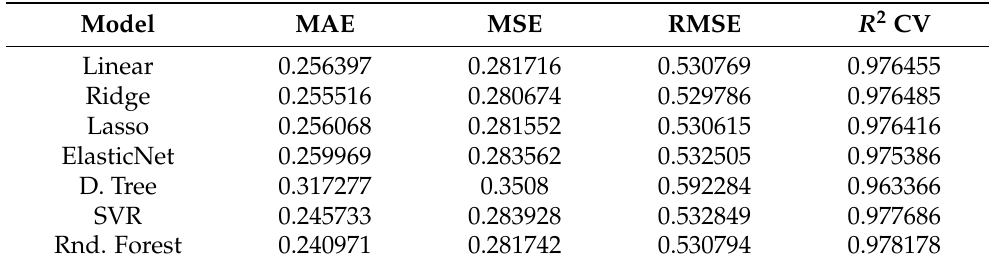
Table 4. Results of the models when they are trained with mesoscale and observed